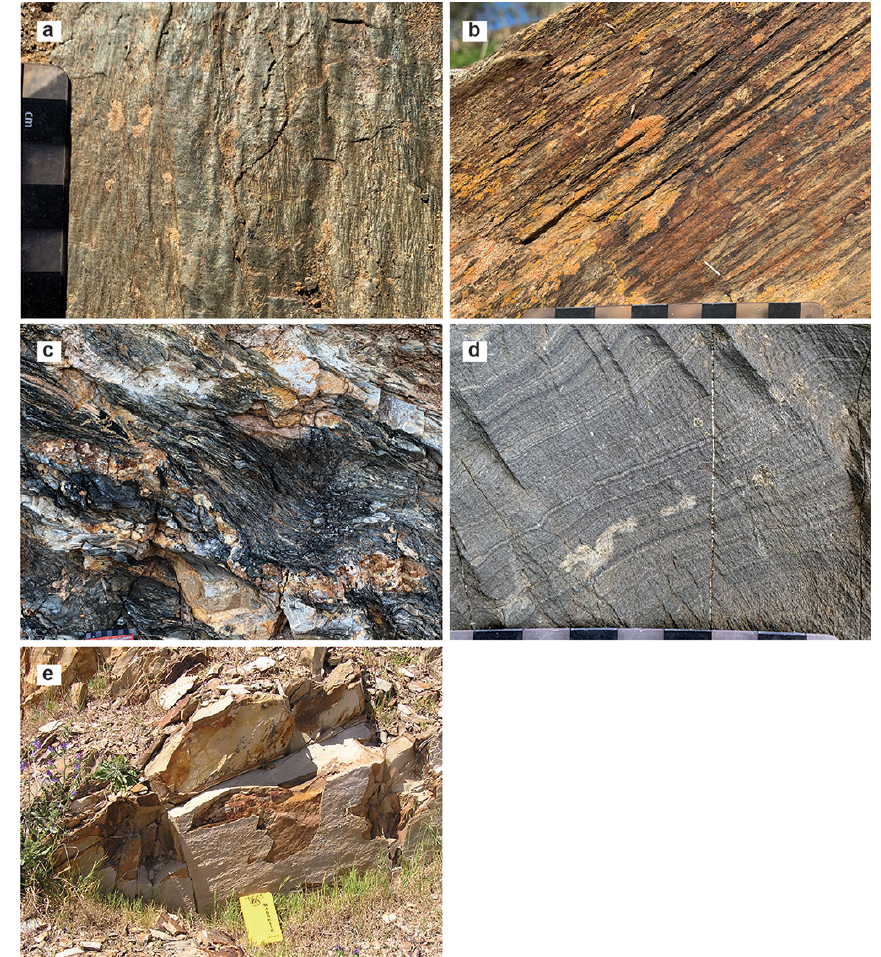
Figure 4. Field photographs of analysed samples. (a) Surface of shear fabric in phyllite from the locality of sample 3779553. (b) Cross section of phyllite at the location of sample 3779552, with a view pointed towards the south and a moderate east-dipping deformation fabric. Note that the orange material is lichen. (c) Cross section of phyllite of sample 3779551. This field of view shows rafts of quartzite within the phyllite and complex buckling of the phyllitic-foliation in places with a new shear fabric that developed associated with these structures. (d) Detail of laminated metasiltstone of sample 3779554, showing high-angle slaty cleavage and dipping steeply to the southeast (field of view looking north). (e) Volcaniclastic sediment of the Heatherdale Shale from the locality of sample